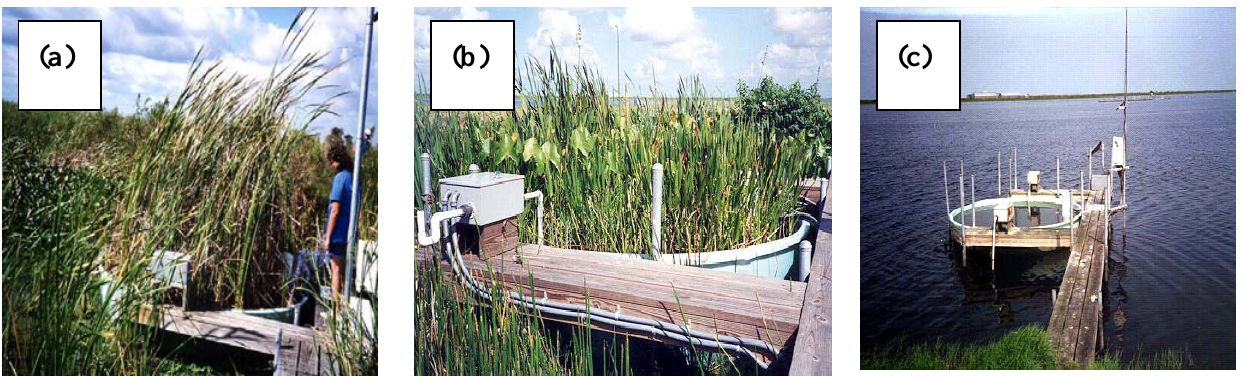
Figure 1. Automated lysimeters in three surface covers (a) cattails, (b) mixed marsh and (c) open